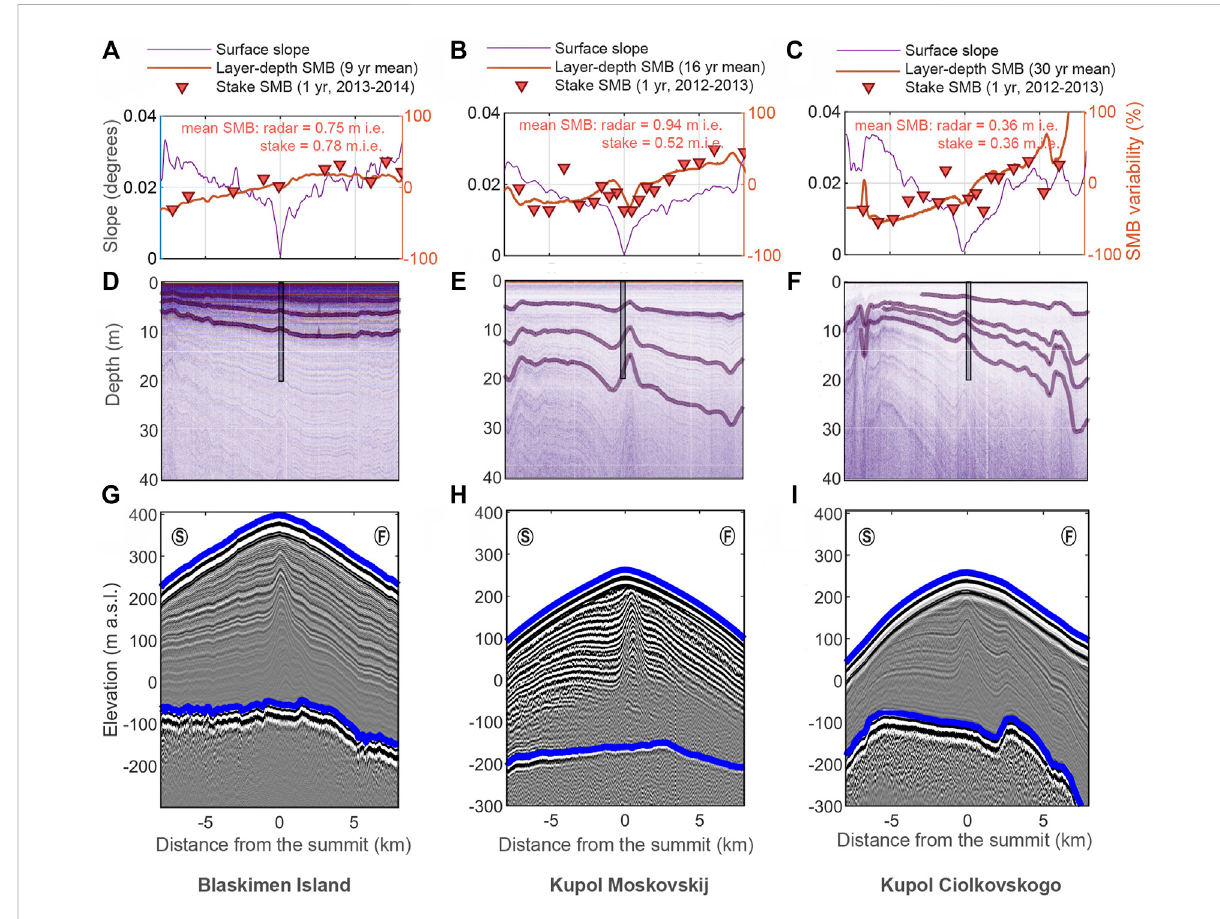
FIGURE 3 Surface mass balance and shallow and deep sounding radargrams over ice rises in the Fimbul region. Subpanels in each column show the data and results from Blåskimen Island, Kupol Moskovskij, and Kupol Ciolkovskogo, respectively. Data from Blåskimen Island (A, D, and G) have been published earlier (Goel et al., 2017). Panels in the fi rst row (A – C) show surface slope pro fi les across the ice rises, as well as spatial patterns of radar- measuredandstake-measuredSMBnormalizedbyrespectivemeans.Panelsinthesecondrow (D – F)